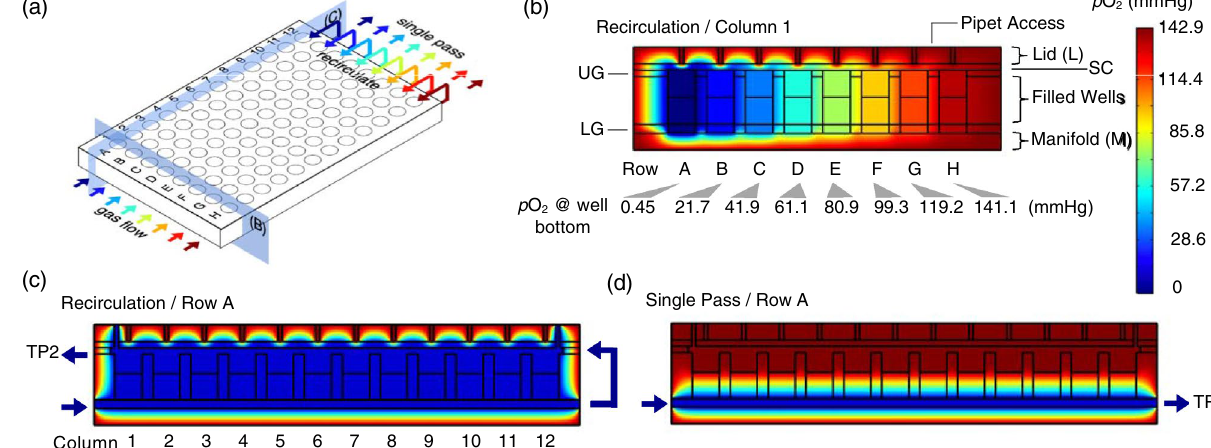
Figure 1. Plate Design and Modeling. ( a ) Diagram of the plate cross-sections used to mathematically model the oxygen distribution. Arrows show the direction of gas flow and are color-coded to represent the p O 2 levels. ( b ) Heat map of the predicted oxygen distribution generated across eight rows A–H in Column 1 of media- filled wells by delivery of eight different gas mixtures recirculated from the lower to the upper channels. Labels indicate the acrylic lid (L) and manifold (M), the silicone cover (SC) and the upper and lower channels formed by the rubber upper gasket (UG) and lower gasket (LG), respectively. The predicted pO 2 levels at the bottom of wells in each row are listed below the row letter. ( c ) Heat map of predicted oxygen distributions along Row A when gas is recirculated and ( d ) in Row A when gas is in single-pass mode. Oxygen sensors measure the p O 2 levels at test points 1 (TP1) and 2